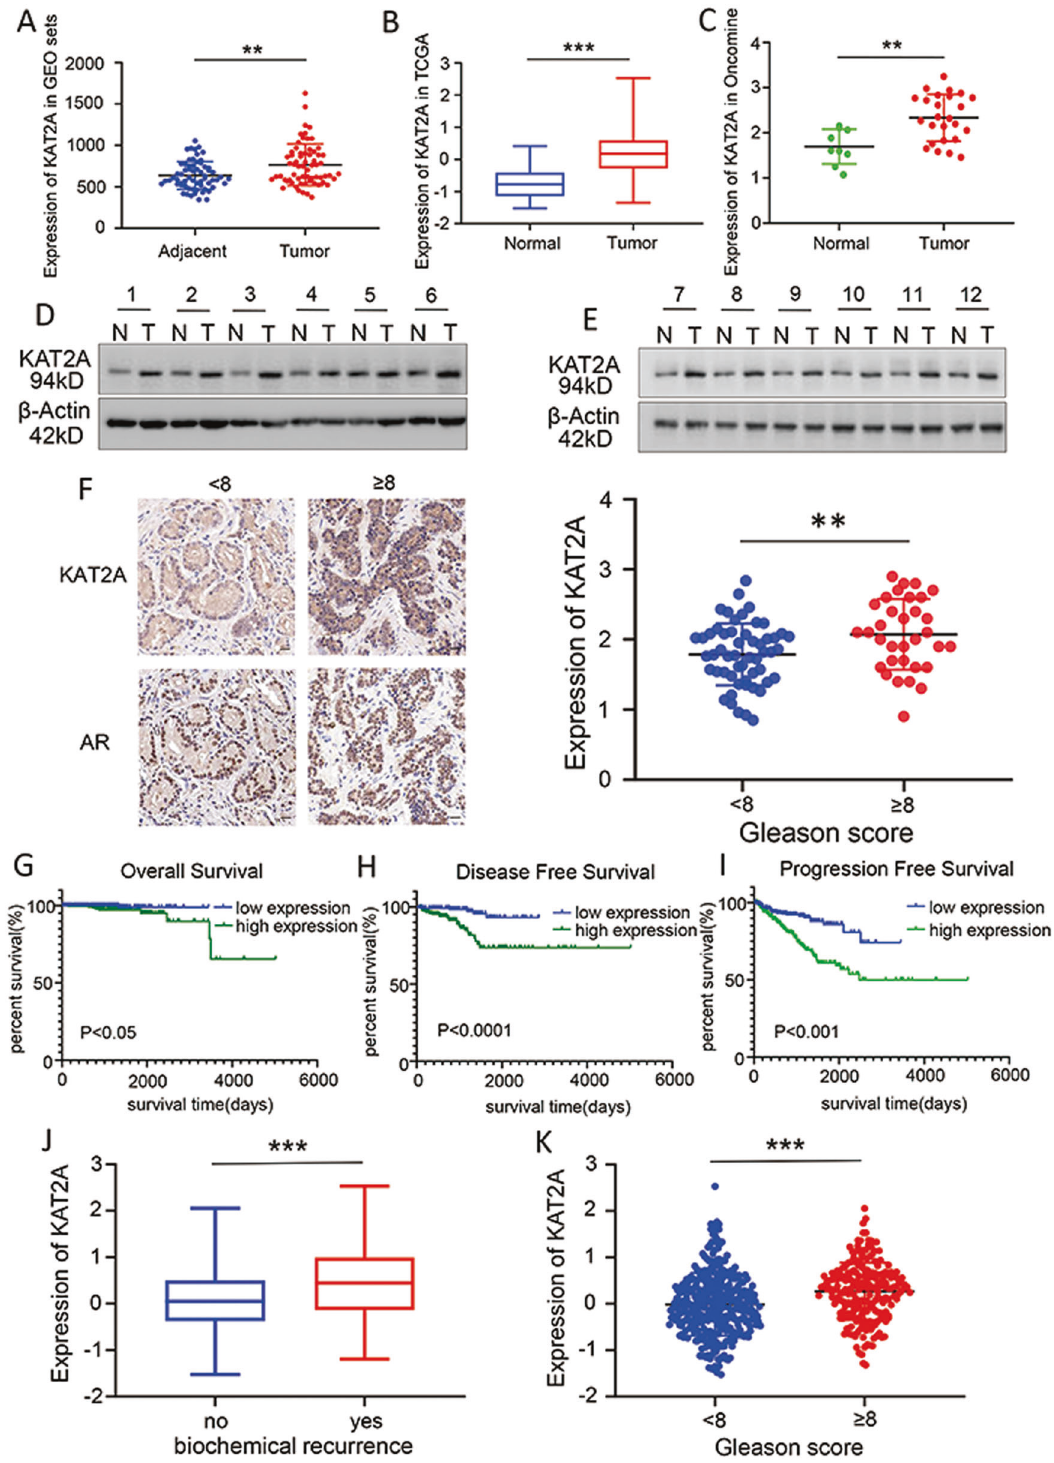
Fig. 1 KAT2A is up-regulated in PC tissues and is correlated with worse prognosis. A – C The expression levels of KAT2A in adjacent/normal and tumour were searched in GEO, TCGA, Oncomine respectively. D, E Specimens were strati fi ed into “ GS < 8 group ” and “ GS ≥ 8 group ” according to Gleason score (GS), followed by random selection of 6 samples from each group for subsequent western blot experiments. (N: normal, T: tumour). F The correlation between KAT2A, AR expression level and Gleason score were identi fi ed by IHC with 54 patients in the “ GS < 8 group ” and 33 patients in “ GS ≥ 8 group ” . G – I OS, DFS, PFS were analysed according to high or low expression of KAT2A and log-rank t test was used. J The correlation of KAT2A expression and biochemical recurrence. K The correlation of KAT2A expression and Gleason score. * p < 0.05, ** p < 0.01, *** p <